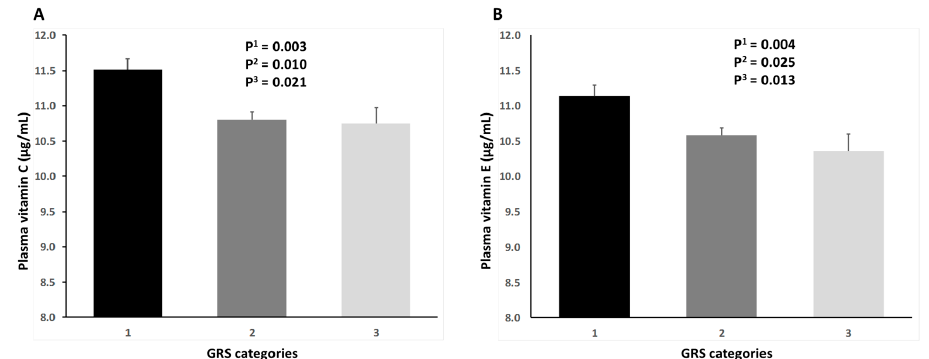
Figure 2. Plasma concentrations of vitamin C (panel A ) and vitamin E (panel B ) depending on the genetic risk score (GRS) as a categorical variable: category 1 (0–1 risk alleles); category 2 (2–3 risk alleles); and category 3 (4–8 risk alleles). P 1 : p -value for the unadjusted comparison of means. P 2 : p -value obtained in the model adjusted for the POAG status. P 3 : p -value obtained in the model adjusted for POAG status, age and sex. Error bars are SE of means.